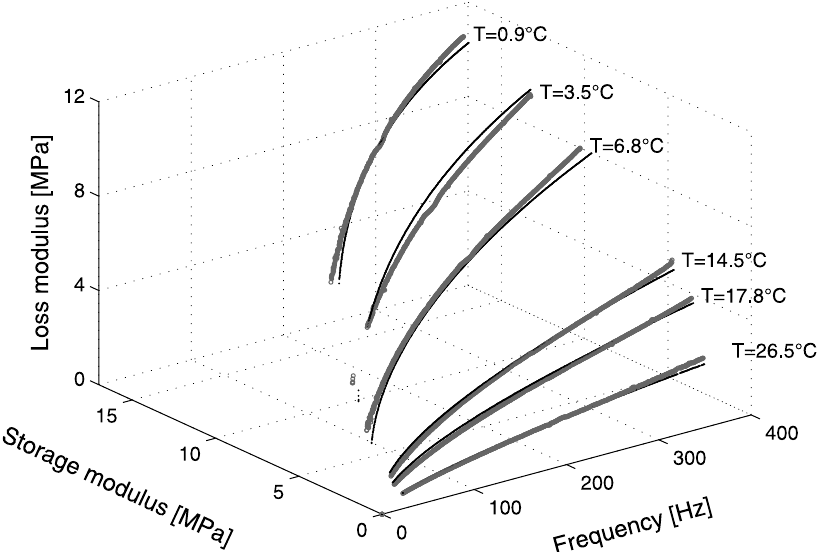
Fig. 8. Complex modulus representation for the frequency-temperature fractional derivative model (grey circles represent experimental data and black points the corresponding model representation). Figure 7 represents the experimental complex modulus data master curve along with the fractional derivative model curves (parameters listed in Table 1). A good agreement between the experimental data and the numerical model representation is